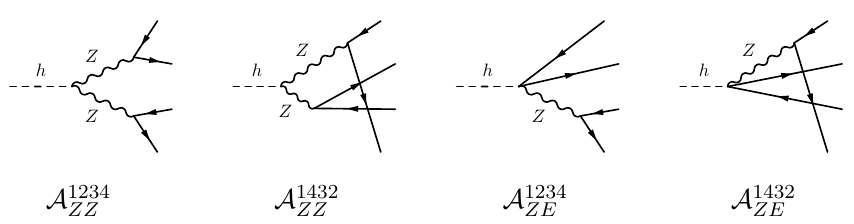
Figure 6 . Current contractions allowed in the presence of 2 pairs of identical particles in (cid:12)nal state.